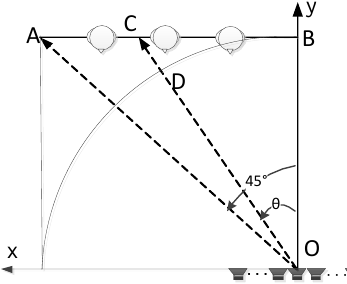
Figure 1. The displacement of the compact line loudspeaker array and the seats of